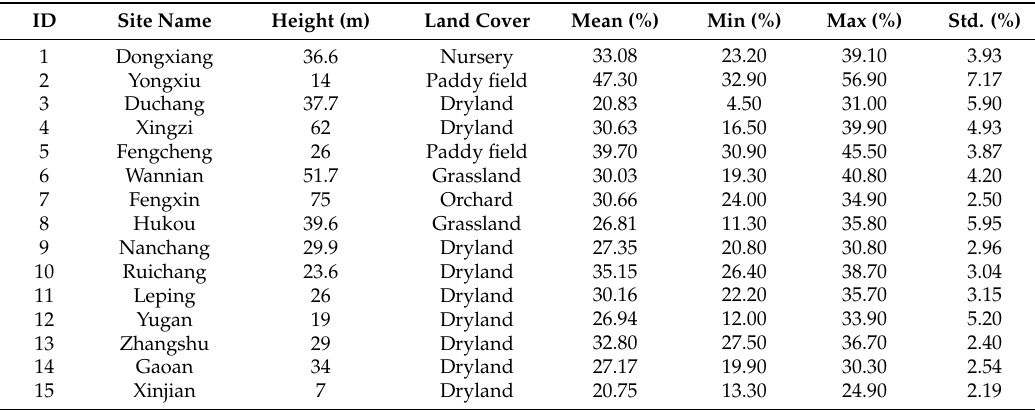
Table 2. Descriptive statistics of 15 soil moisture observation